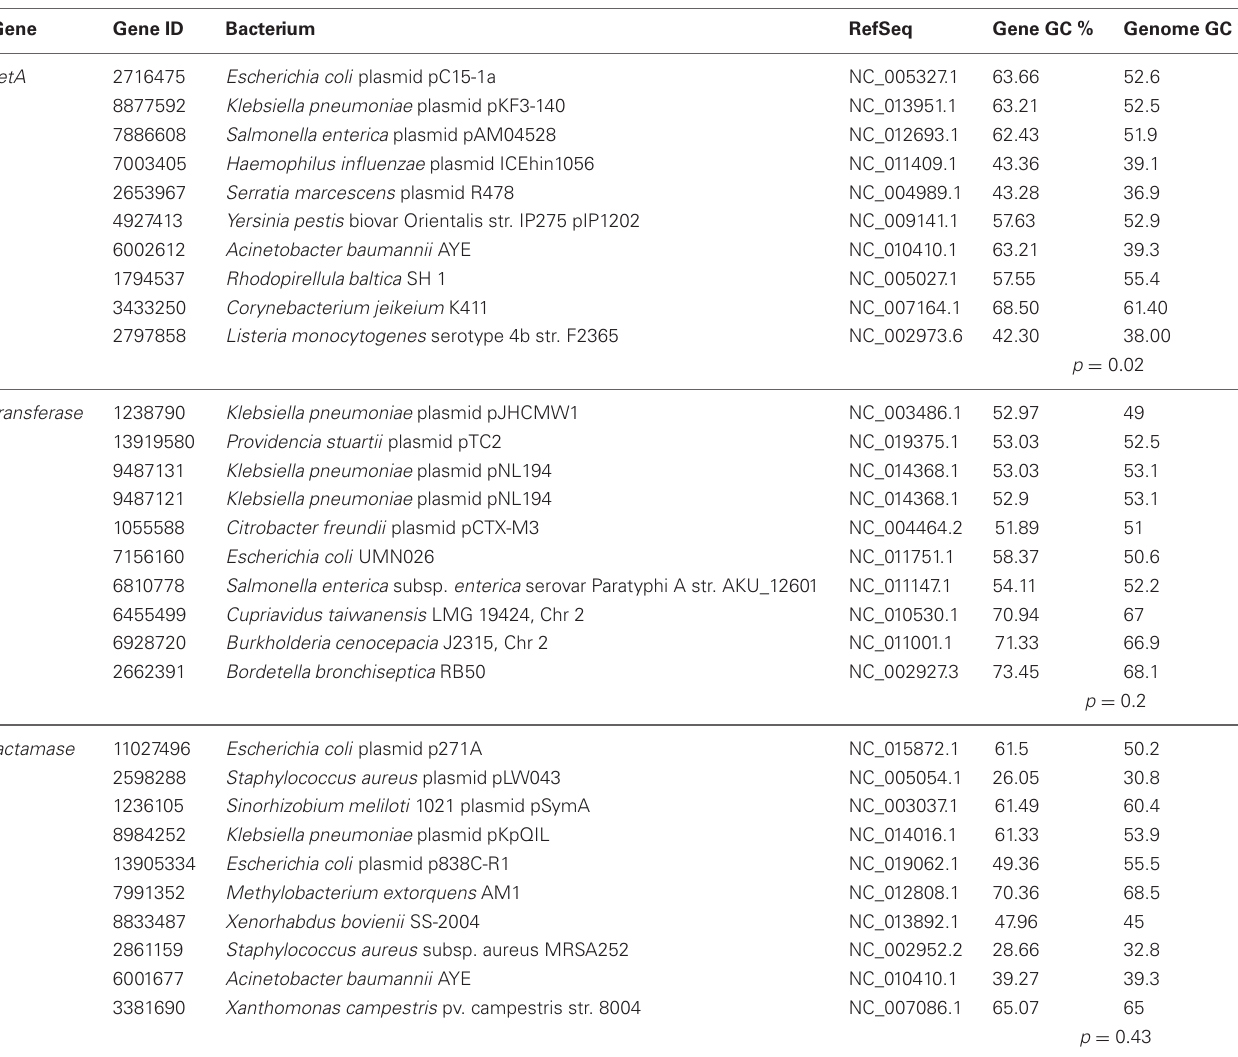
Table 1 | The GC content of tetA , aminoglycoside transferase , and β - lactamase was retrieved from NCBI and compared to that of the respective genomic GC